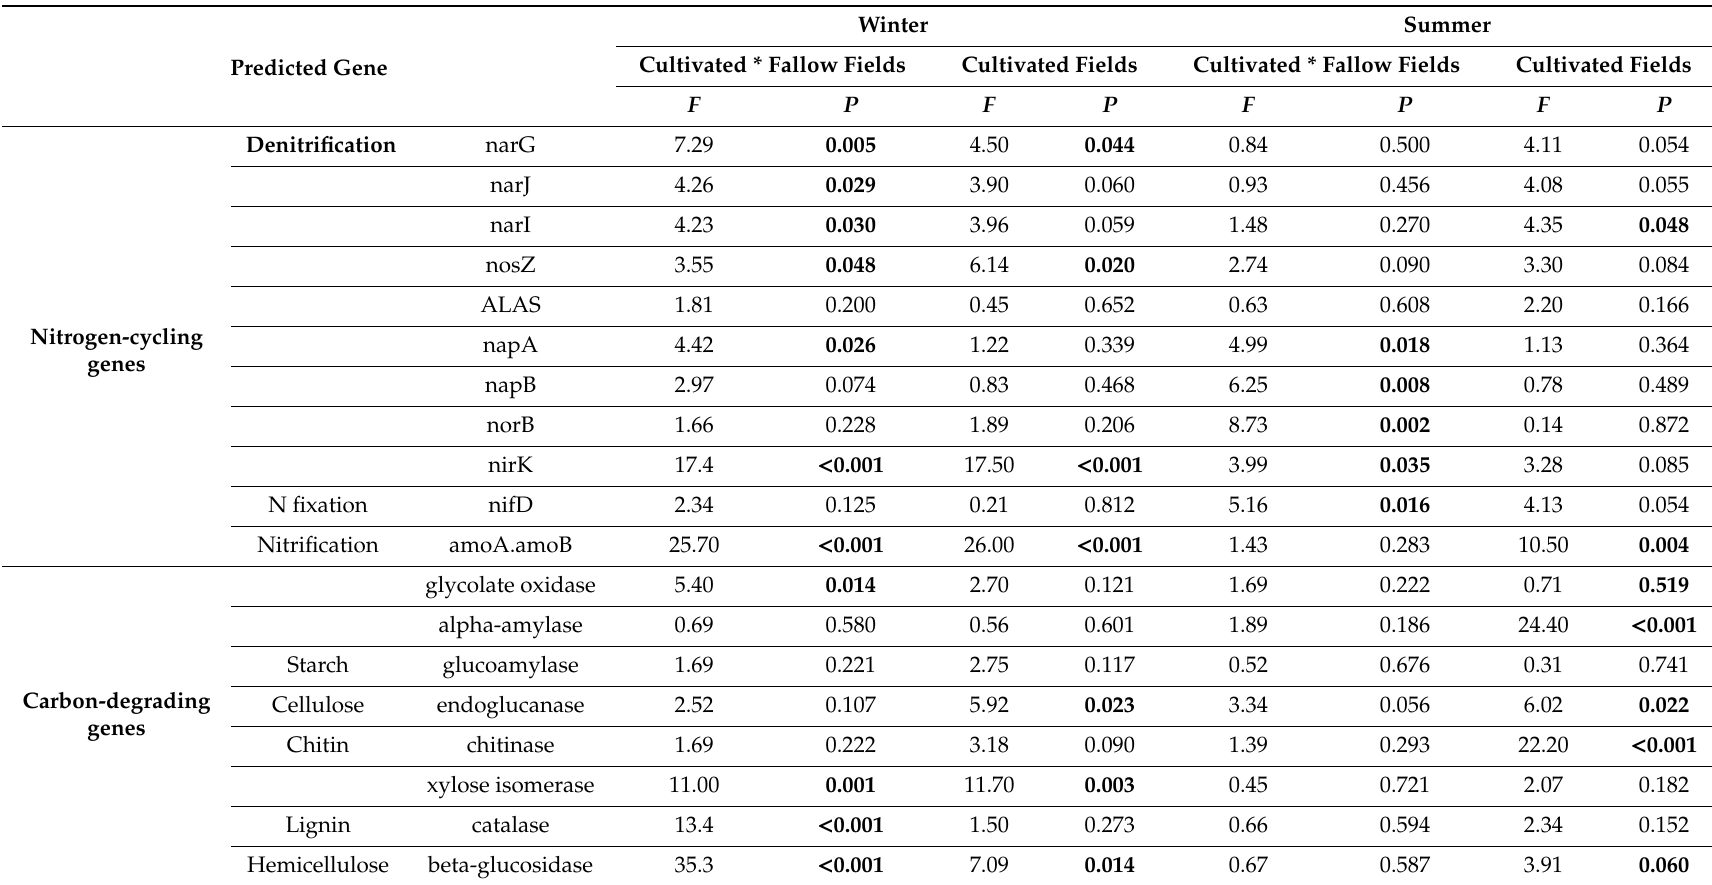
Table 2. The relative abundance of predicted nitrogen and carbon cycling genes in two seasons (winter and summer). Significant P -values indicated in bold. NCS, fallow field soil; CyS1, one-year C. chinensis cultivated soil; CyS3, three-year C. chinensis cultivated soil; CyS5, five-year C. chinensis cultivated soil. Winter Summer Cultivated * Fallow Fields Cultivated Fields Cultivated * Fallow Fields Cultivated Predicted Gene